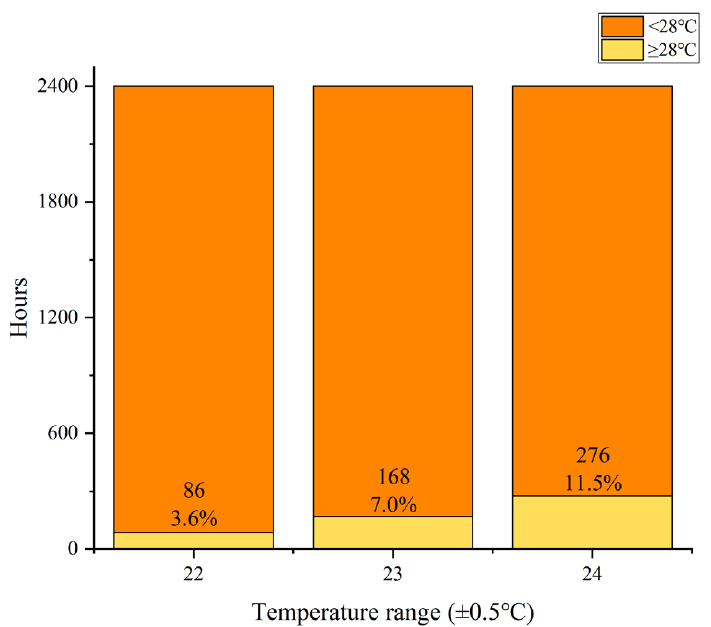
Figure 5. The hours and proportions of temperatures above 28 °C.